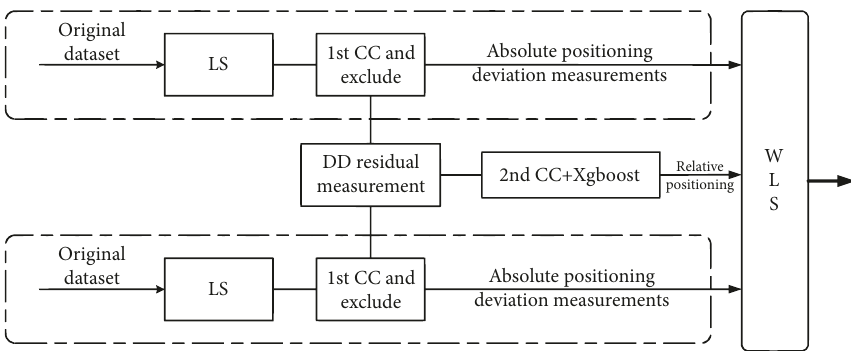
Figure 3: The proposed positioning model